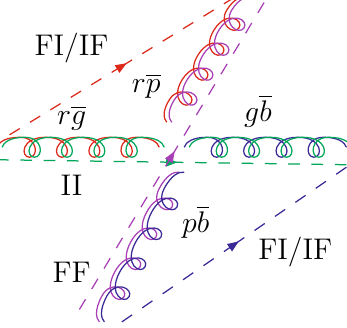
Fig. 1 Colour flow for the process g ( rg ) + g ( gb ) → g ( r p ) + g ( pb ) . Here, the N C → ∞ limit is used so that p stands for the new colour purple. The dashed lines represent the colour lines stretching between the dipole ends. The type of dipole is indicated